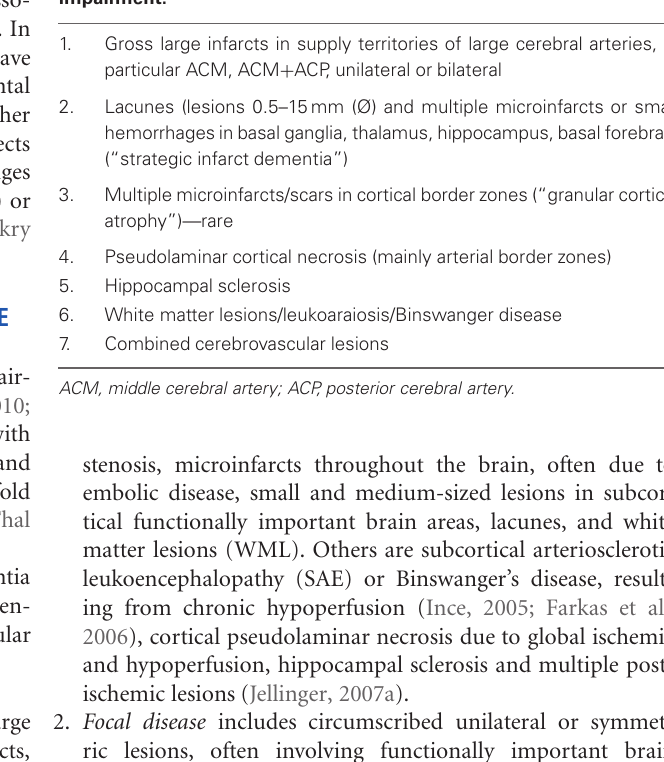
Table 6 | Major cerebrovascular lesions associated with cognitive